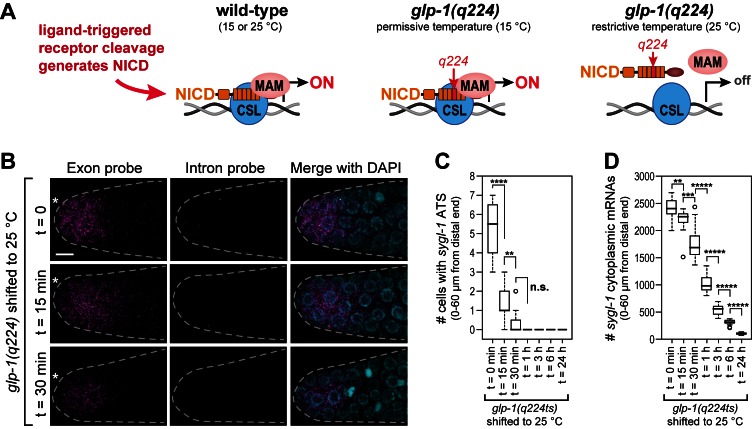
The sygl-1 transcriptional response is abolished in glp-1(q224) mutant germ cells at the restrictive temperature.(A) Schematics of GLP-1/Notch-dependent nuclear complex in wild-type and glp-1(q224) temperature-sensitive mutant. Left, wild-type GLP-1/Notch intracellular domain (NICD) is cleaved from receptor and assembles into a complex in the nucleus to activate transcription; middle, glp-1(q224) NICD has a missense mutation in its fourth ankyrin repeat (red) but can assemble into the complex at the permissive temperature; right, glp-1(q224) NICD fails to assemble into the complex at the restrictive temperature. Effect of glp-1(q224) on complex formation from Petcherski and Kimble (2000). CSL, Notch-specific DNA-binding protein; MAM, mastermind-like transcriptional coactivator. (B-D) glp-1(q224) homozygous adults were raised at the permissive temperature (15°C) and then shifted to the restrictive temperature (25°C) for defined time intervals. Dissected gonads were probed for sygl-1 transcripts with smFISH. n ≥ 20 gonads for each time point. The wild type sygl-1 transcriptional response is essentially the same at 15, 20 and 25°C (Figure 5—figure supplement 1). (B) Z-projections after shift to the restrictive temperature for 0 min (top), 15 min (middle) and 30 min (bottom). sygl-1 exon probes (magenta); sygl-1 intron probes (yellow); and DAPI marks nuclei (blue). Conventions and scale as in Figure 1E. (C,D) smFISH signals for sygl-1 ATS (C) or mRNAs (D) were analyzed in all cells in the region of 0–60 µm (1–13 gcd) from distal end. Asterisks indicate p-value range by t-test. *p<0.05; **p<0.01; ***p<0.001; ****p<0.0001; *****p<0.00001; n.s.: not significant (p>0.05).